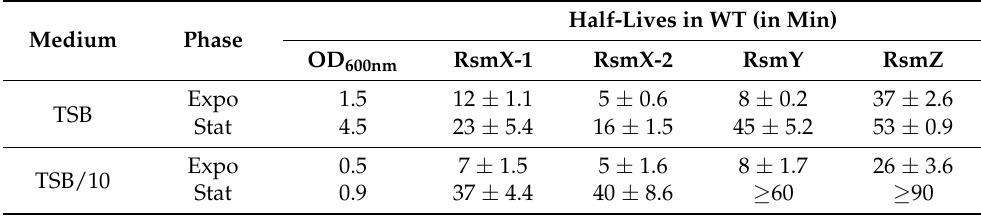
Table 2. Stability of Rsm sRNAs. Half-lives of P. brassicacearum NFM421 RsmX-1, RsmX-2, RsmY and RsmZ. Experiments were conducted in